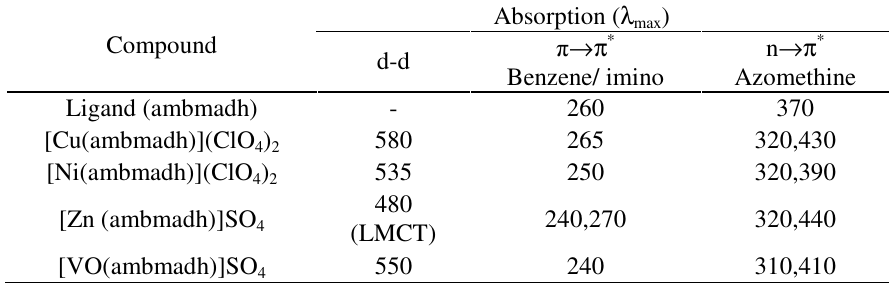
Table 3. Absorption Spectral data (nm) of the ligand and its